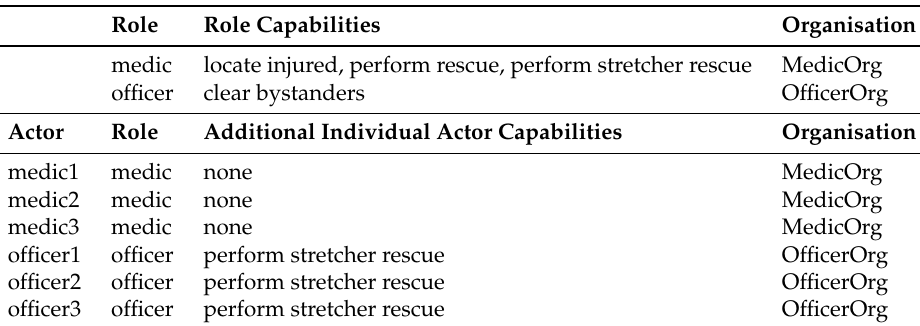
Table 4. Roles and capabilities of agents in a rescue